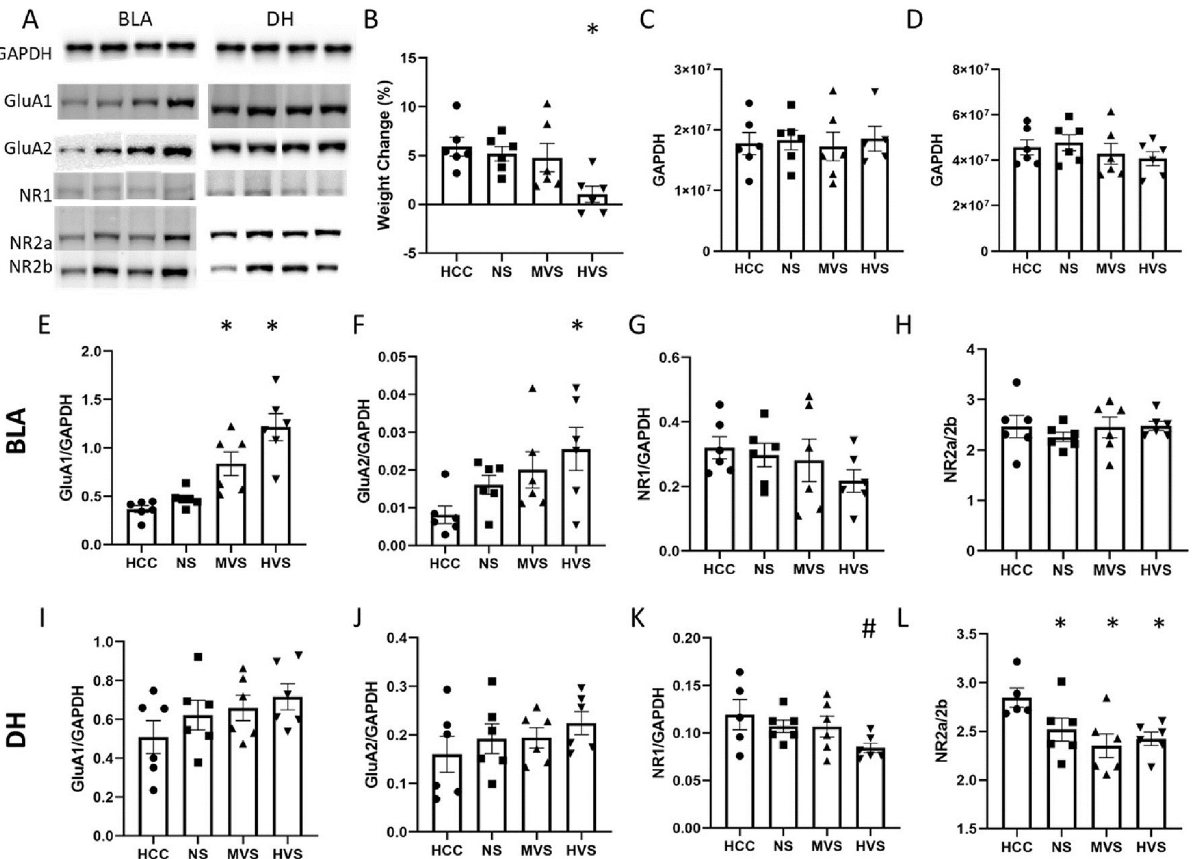
Fig 5. Neurobiological effects of stress volume. Depicted: BLA (panels E-H) and DH (panels I-L) concentrations of GluA1 (panels E & I), GluA2 (panels F & J), NR1 (panels G & K), and NR2a/2b (panels H & L) as determined by western blot analysis. GluA1, GluA2, and NR1 are depicted as a ratio over GAPDH concentrations (panels C & D). Rats were exposed to 0 (NS), 15 (MVS), or 100 (HVS) tailshocks, or remained in their home cage (HCC) never exposed to context or a stressor, one week prior to sacrifice for tissue analysis. Rats were weighed prior to stress exposure and prior to sacrifice. MVS and HVS groups exhibited higher BLA concentrations of GluA1 compared to HCC and NS groups. The HVS exhibited higher concentrations of GluA2 compared to the HCC group. The HVS group had a lower concentration of DH NR1 when compared to NS. All groups exhibited a lower NR2a/ 2b ration in the DH when compared to the HCC group. Error bars denote mean ± SEM. � p < .05 (compared to HCC), # p < .05 (compared to